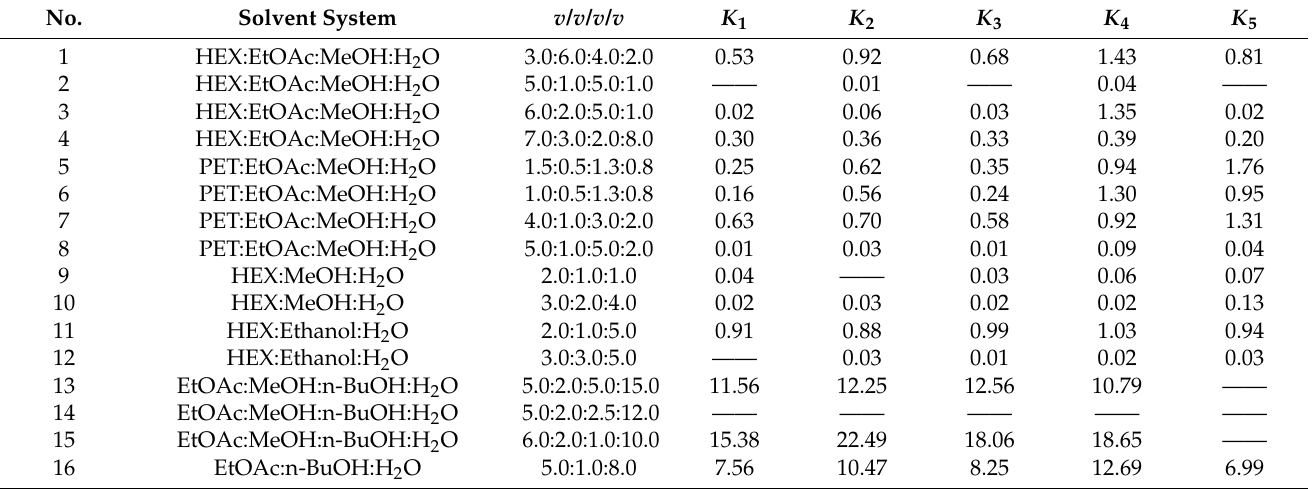
Table 2. Partition coefficient ( K ) values of isoflavones from P. cocos in different two-phase solvent systems.